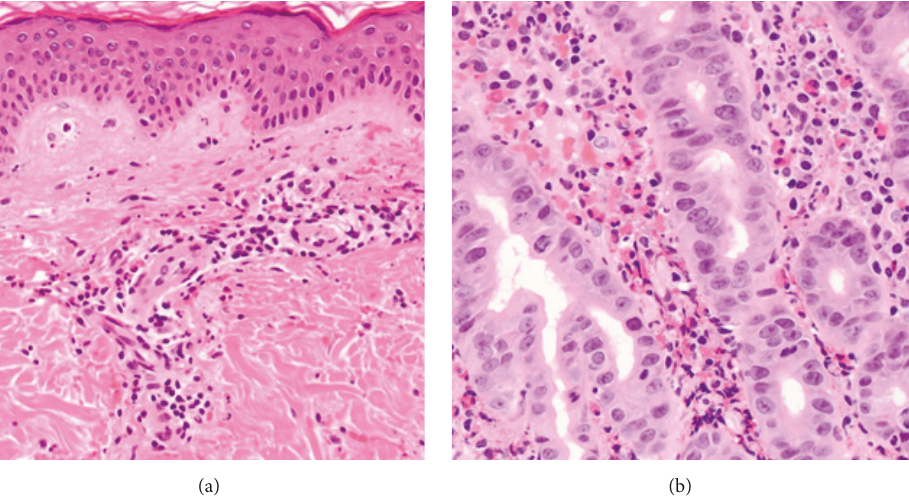
Figure 2: Histopathological findings. (a) Skin biopsy specimen shows neutrophil infiltrations around vessels in the upper dermis, also known as leukocytoclastic vasculitis (hematoxylin and eosin stain; original magnification × 100). (b) Duodenal biopsy specimen shows eosinophil infiltration of the mucous membrane (hematoxylin and eosin stain; original magnification × 400).